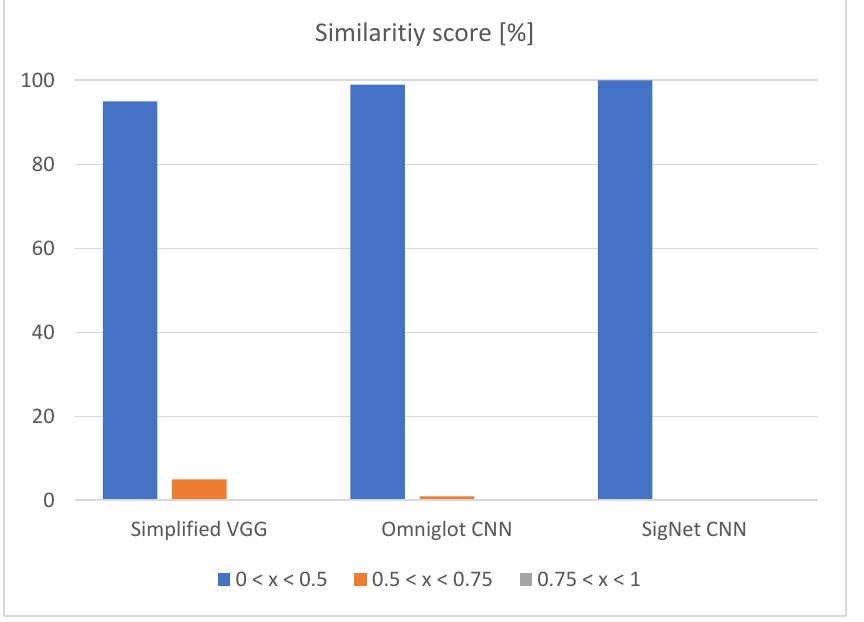
Figure 6. Input vs. highest similarity image from each class — similarity score. Table 5. The McNemar’s test with a significance level of 0.05. All model comparisons rejected null hypothesis